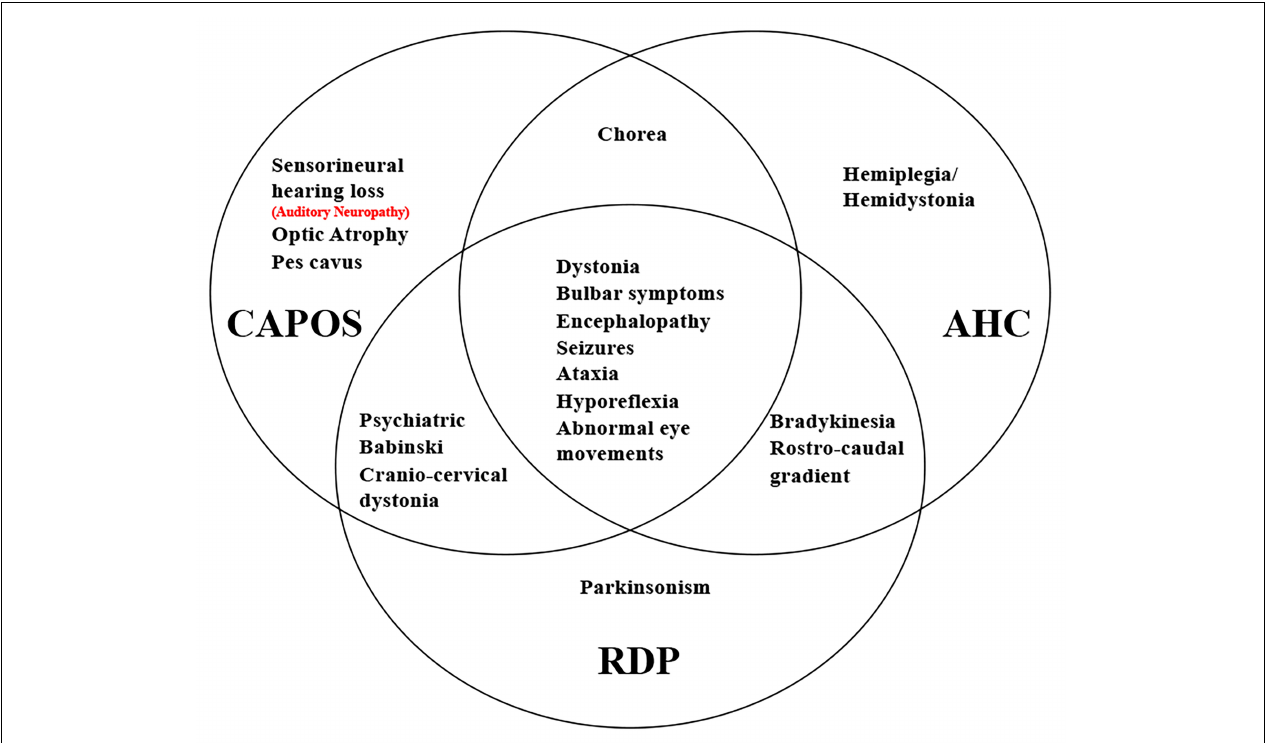
FIGURE 4 | Unique and shared features between AHC, RDP, and CAPOS phenotypes. Auditory neuropathy is either a symptom of CAPOS or a new phenotype of ATP1A3